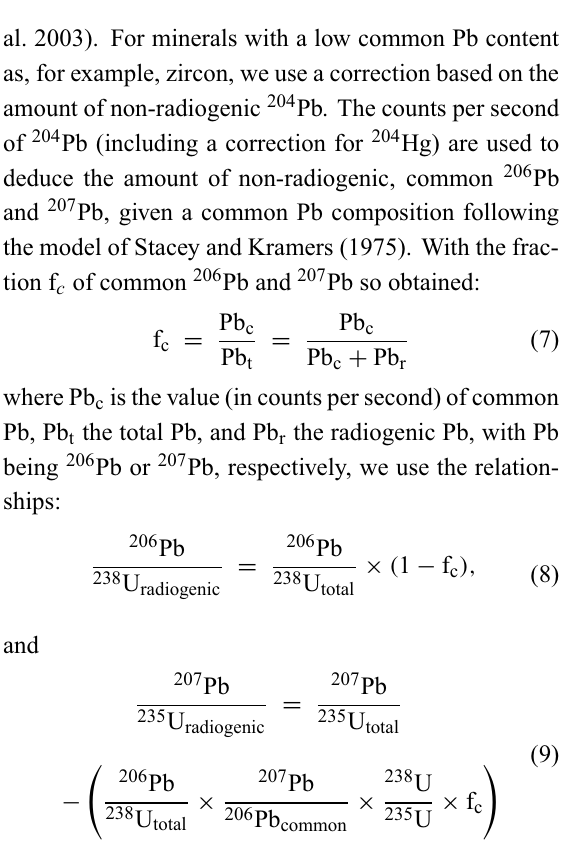
Fig. 3 – Typical signal sequence of a laser ablation experiment. Note that the absolute count rates of the isotopes may vary during the ablation process while the isotope ratios remain constant. The signals of 202 Hg and 204 Hg/Pb, in the case of no common 204 Pb present in the ablated sample, come solely from the Hg contents in the Ar gas, and are therefore not influenced by the ablation